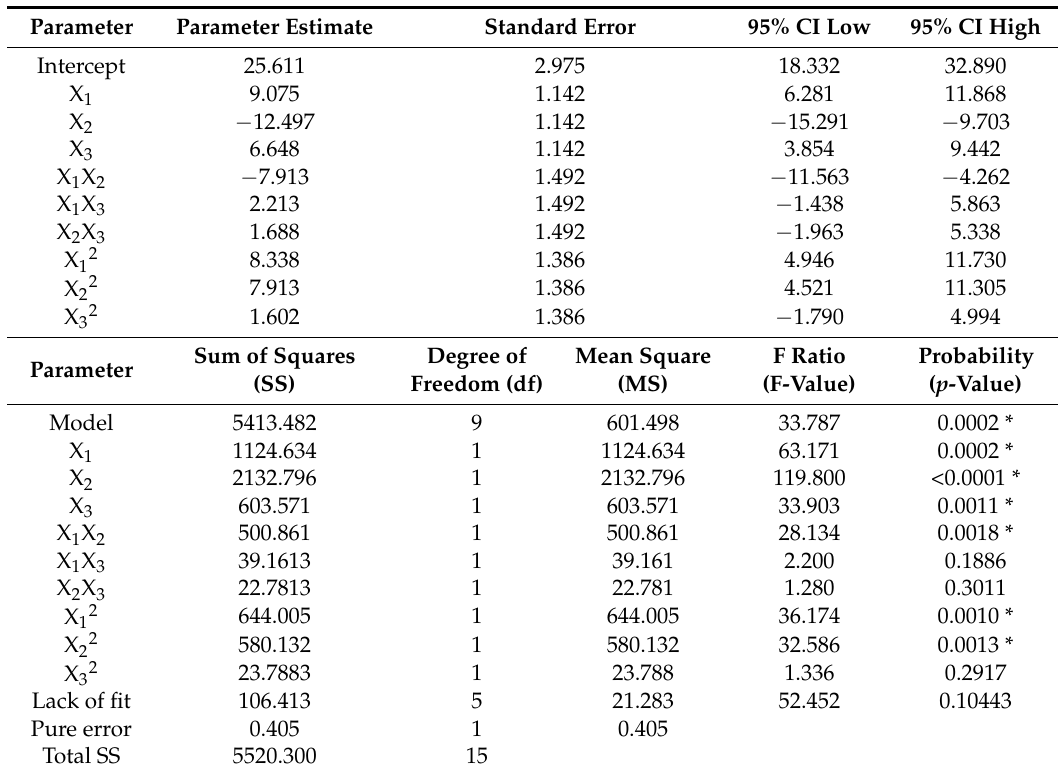
Table 5. Results of the regression model and ANOVA for